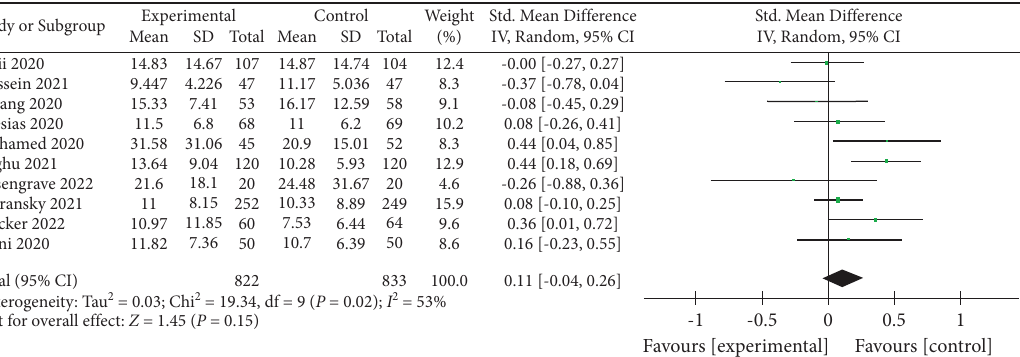
Figure 17: Forest plots for the efect of vitamin C on length of hospital